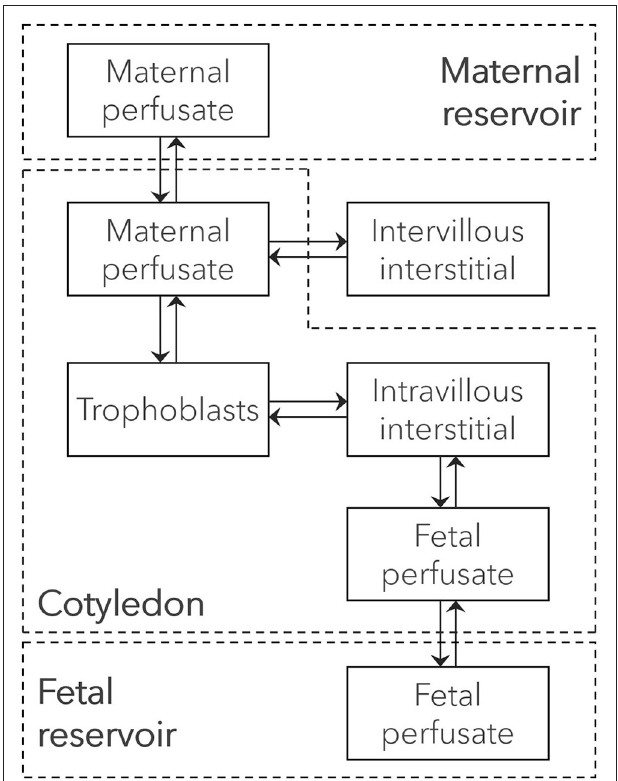
FIGURE 3 | Structure of the ex vivo cotyledon perfusion model. Boxes represent compartments of the novel ex vivo cotyledon perfusion model and solid arrows denote drug transport via the perfusate flow or diffusion. The cotyledon is highlighted as dashed box.